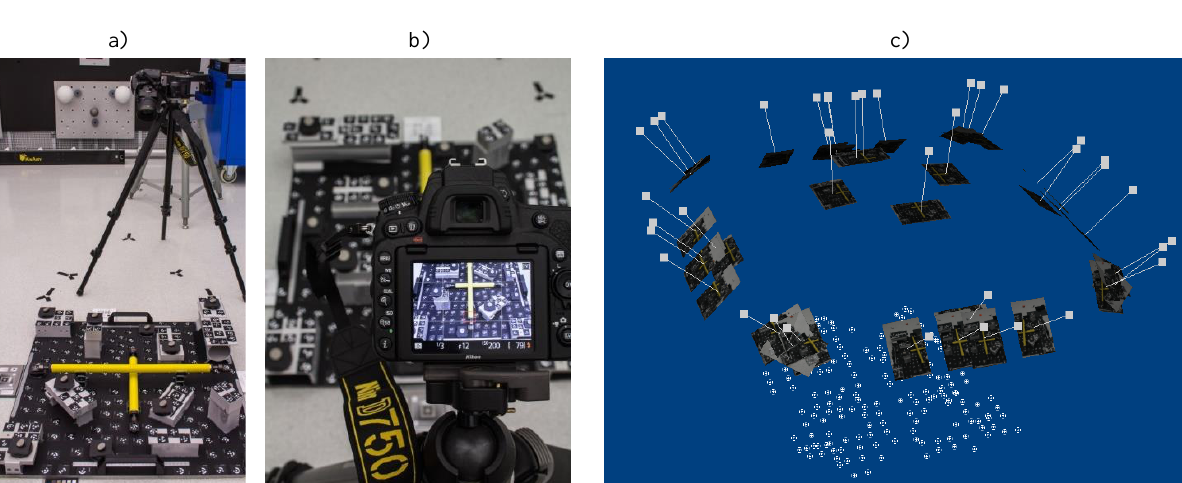
Figure 5. 3D photogrammetric calibration test object (3D PCTO) developed specifically for calibrating the tilt-shift lens (a, b). Example of camera calibration network